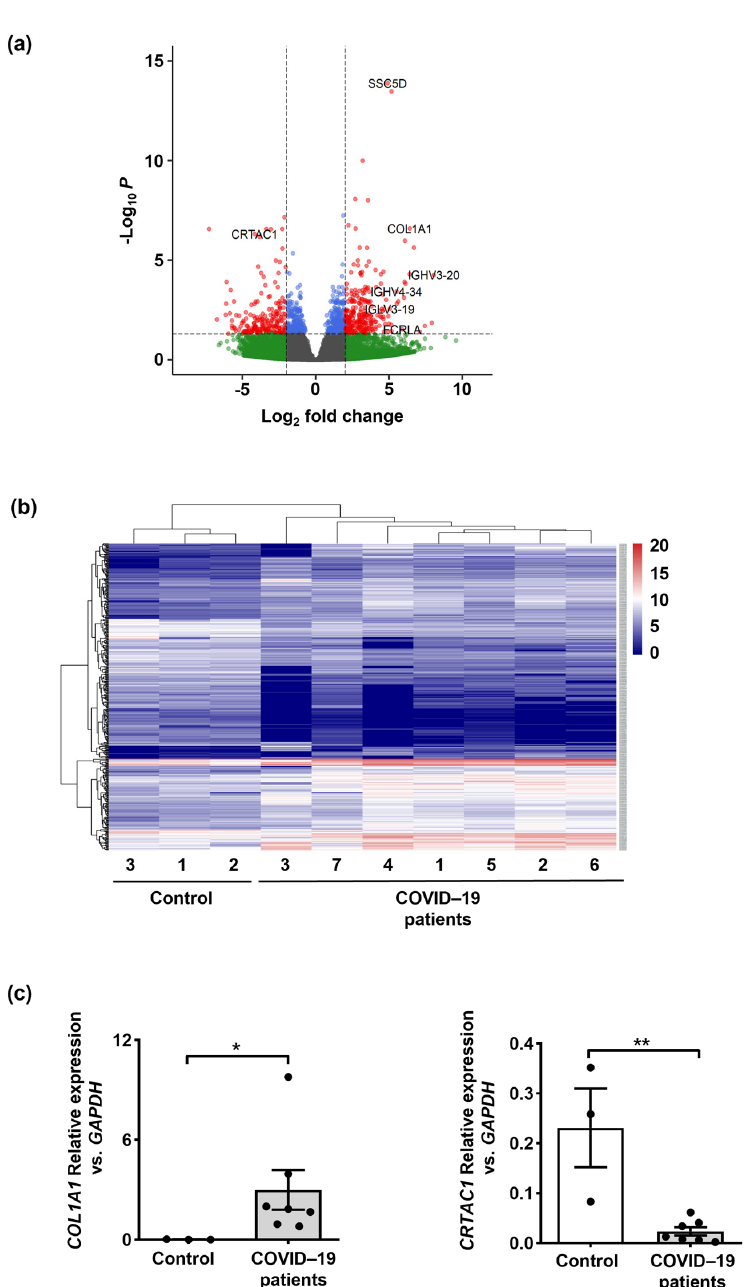
Figure 1. Expression analysis of the lung biopsies from COVID–19 patients and control individuals. ( a ) The volcano plot of differentially expressed genes (DEGs) in COVID–19 patients’ lungs was compared to control donors. A total of 474 DEGs were identified. ( b ) The heatmap of DEGs identified on lung tissue of COVID–19 patients ( n = 7) compared to control donors ( n = 3) for the expression pattern of the selected genes. ( c ) COL1A1 and CRTAC1 mRNA expression levels in lung tissues of COVID–19 patients ( n = 7) compared to control donors ( n = 3) by qPCR confirmed the RNA-seq data. Values are means ± SEM. * p < 0.05; ** p < 0.01.